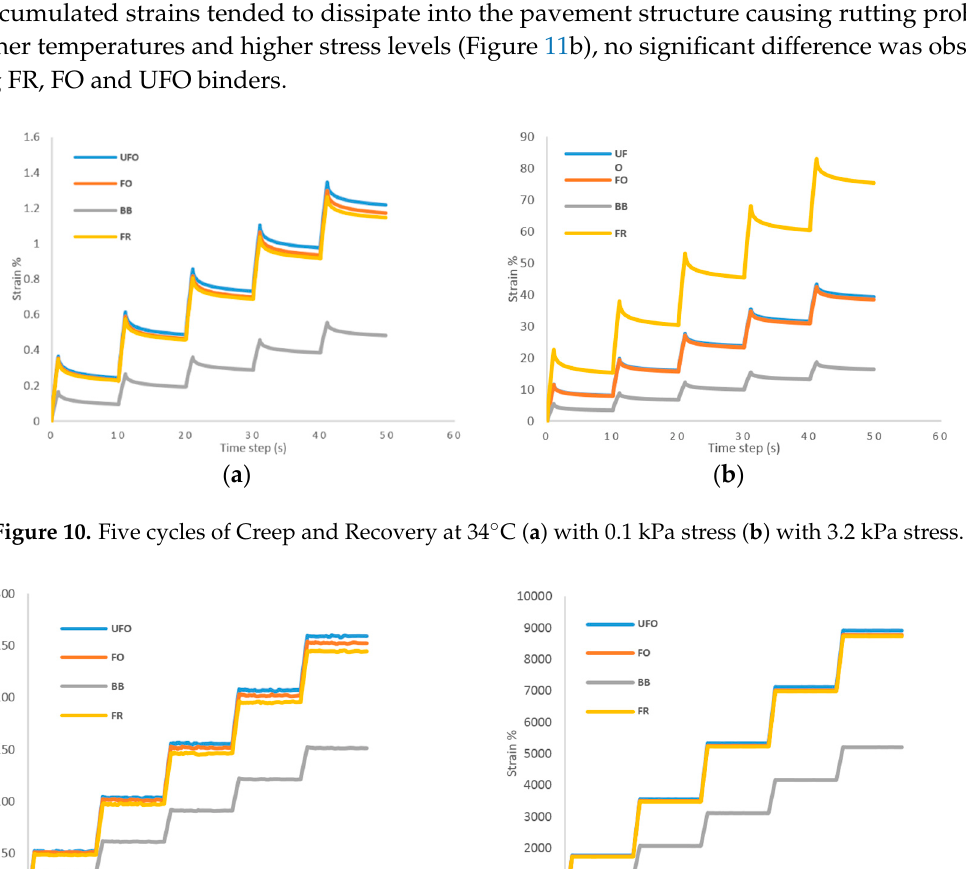
Figure 9. Decrement in high temperature performance grade after RTFO aging.